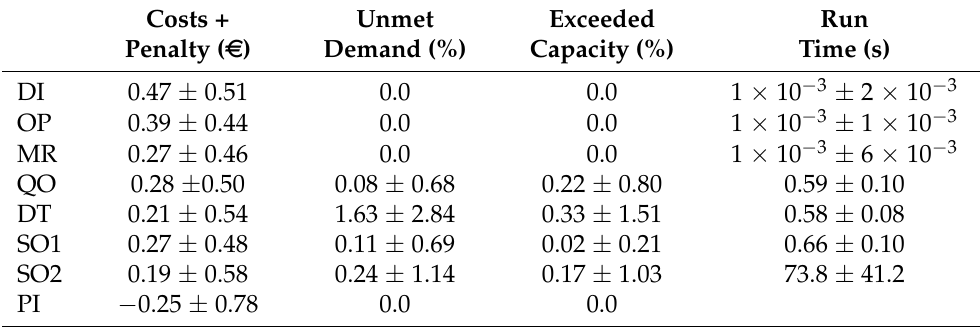
Table 3. Results for the Dutch case study. The values shown are the means ± the standard deviations of the results. The results are averages for one charging session taken across 950 scenarios.